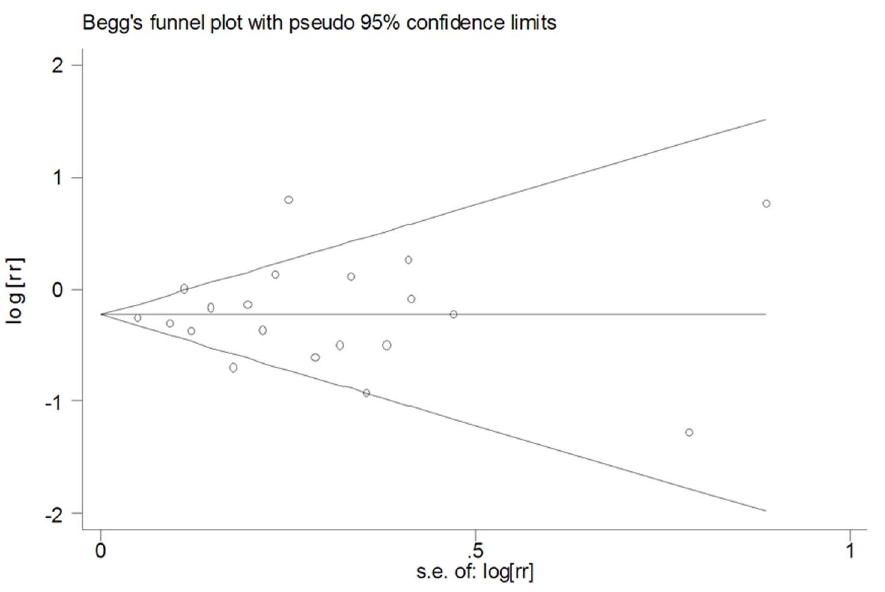
Figure 3. Funnel plot for publication bias in the studies investigating the association between statin use and the risk of haematological malignancies.